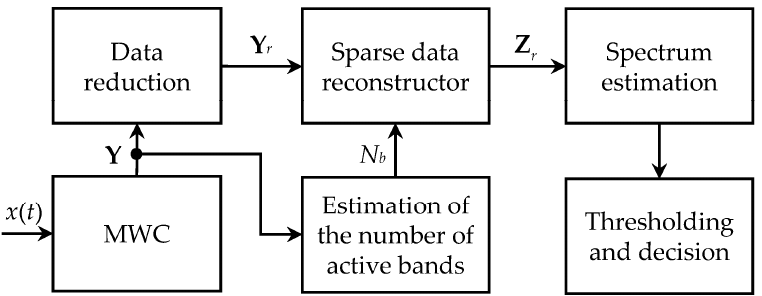
Figure 1. Signal and data processing block diagram for wideband spectrum sensing.